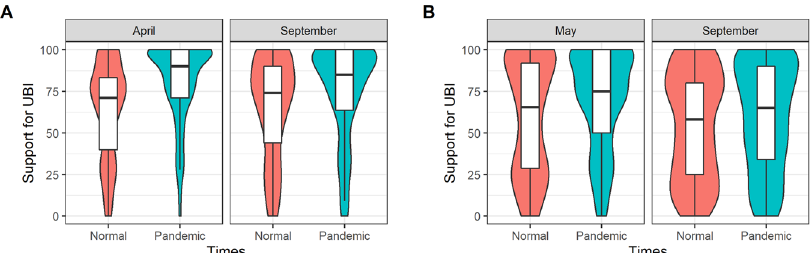
Fig. 6 Support for UBI in study 3. A Boxplots of UBI support in normal and pandemic times, study 3a (September), and the UK participants of study 1 (April). Violins show the distribution of the data. B Boxplots of preference for UBI versus a targeted system in normal and in pandemic times, study 3b (September), and the UK participants of study 2 (May). Violins show the distribution of the